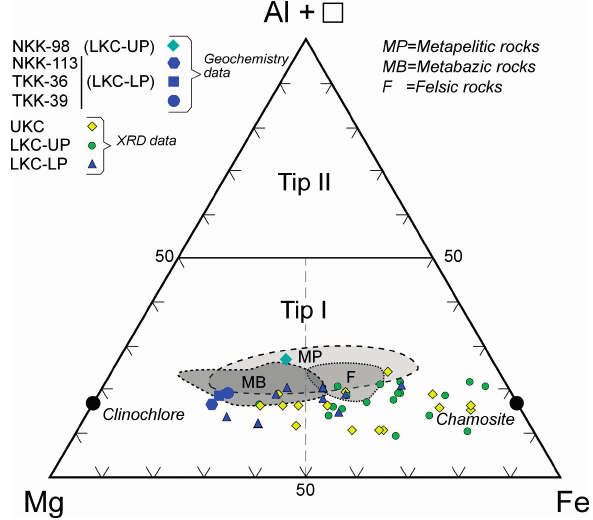
Figure 11. The distribution of chlorites in the Karakaya Complex units in the Al+ □ − Mg − Fe triangular diagram according to octahedral compositions ( □ : Octahedral